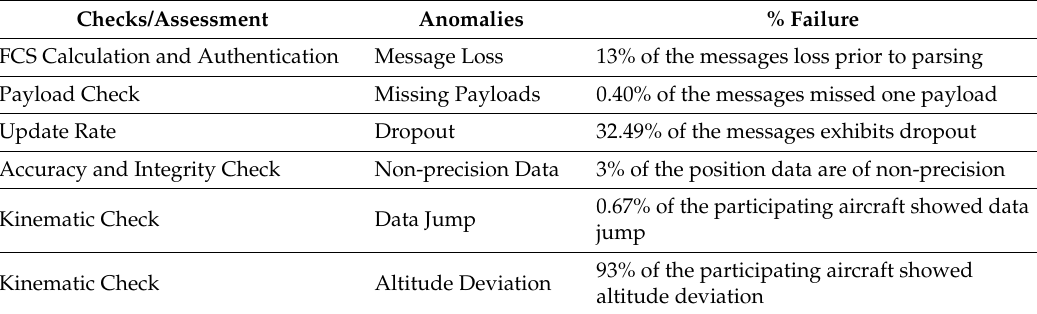
Table 1 . Data anomaly summary adopted from [16]. Table 1. Data anomaly summary adopted from [16].